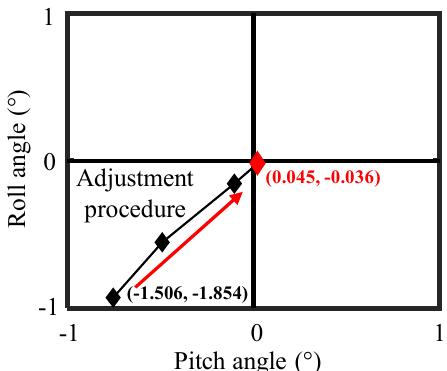
Figure 16. Experimental results of the tilt alignments of the high aspect ratio aspheric workpiece. After that, measurement of the inner profile of the high aspect ratio aspheric workpiece was carried out. First, the lateral gauge was applied to measure the sidewall of the inner profile by simultaneously moving the Z -slide along the negative Z -axis and the Y -slide along the Y -axis. The measurement of the lateral gauge started from the top edge to the bottom of the workpiece. The moving distance of the Y -slide and the Z -slide was 30.00 and 138.28 mm, respectively. The moving speed of the Y -slide and the Z -slide was set to be 0.05 and 0.23 mm/s, respectively. During the measurement procedure, the position of the Y -slide, the position of the Z -slide and the lateral gauge measurement were recorded in real-time. Then, the axial gauge was used to measure the bottom part of the inner profile of the workpiece by only moving the Y -slide along the Y -axis for about 20 mm. The measurement of the axial gauge started from the central axis of the workpiece, and the moving speed was about 0.07 mm/s. During the measurement procedure, the position of the Y -slide and the output of the axial gauge were recorded in real-time. The whole measurement time was about 15 min. The data of the measurement were analyzed and shown in the next section.